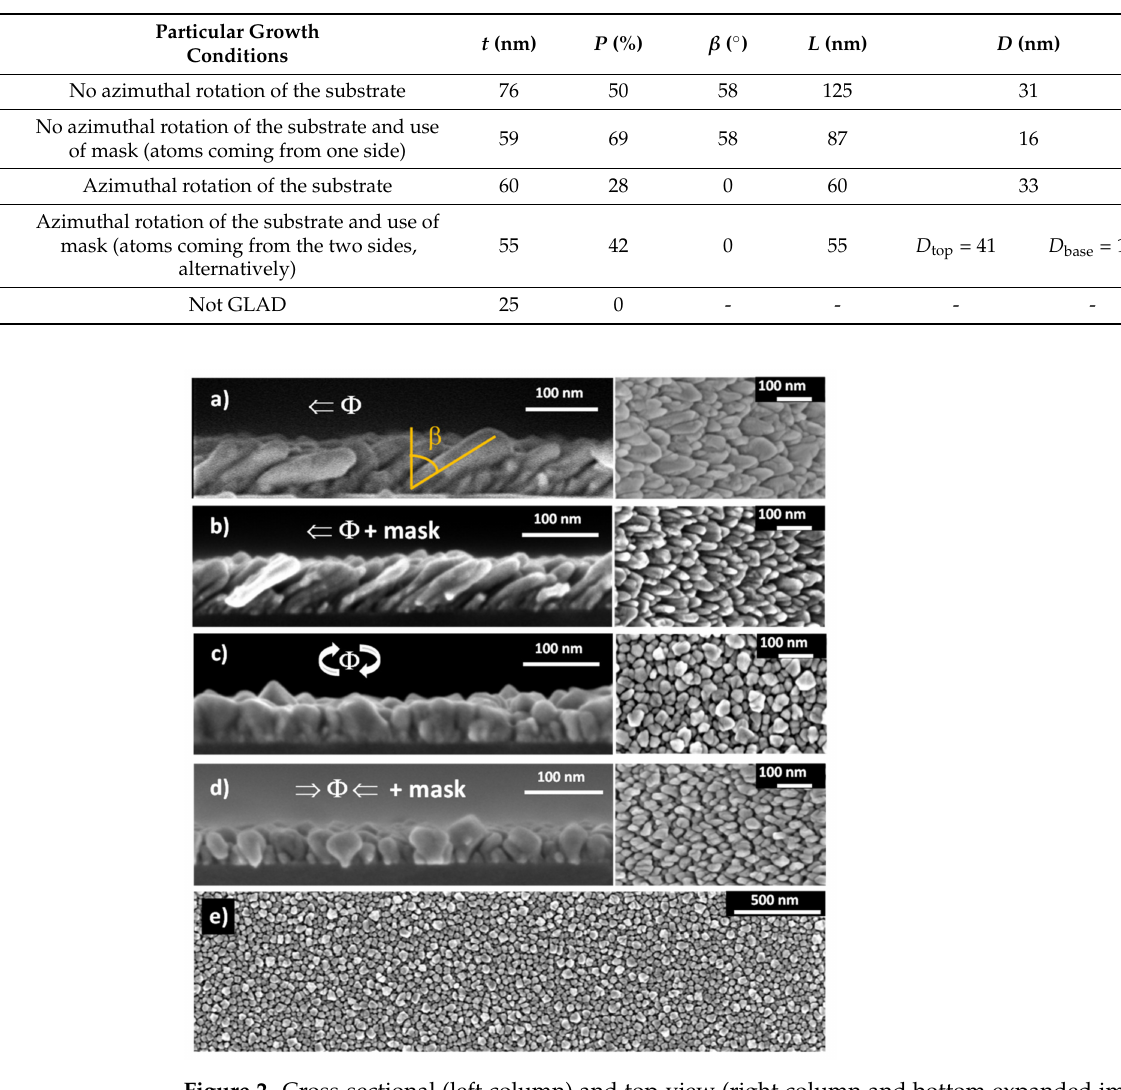
Figure 2. Cross-sectional (left column) and top-view (right column and bottom expanded image) SEM images of 100 min MS-GLAD Fe deposition onto Si substrate with σ = 85 ◦ of: ( a ) NR sample: no azimuthal rotation of the substrate; ( b ) NR-mask: no azimuthal rotation of the substrate and use of mask (one side deposition); ( c ) R sample azimuthal rotation of the substrate; and ( d ) R-mask: azimuthal rotation of the substrate and use of collimation mask (two sides deposition). ( e ) Large area top-view of ( c )